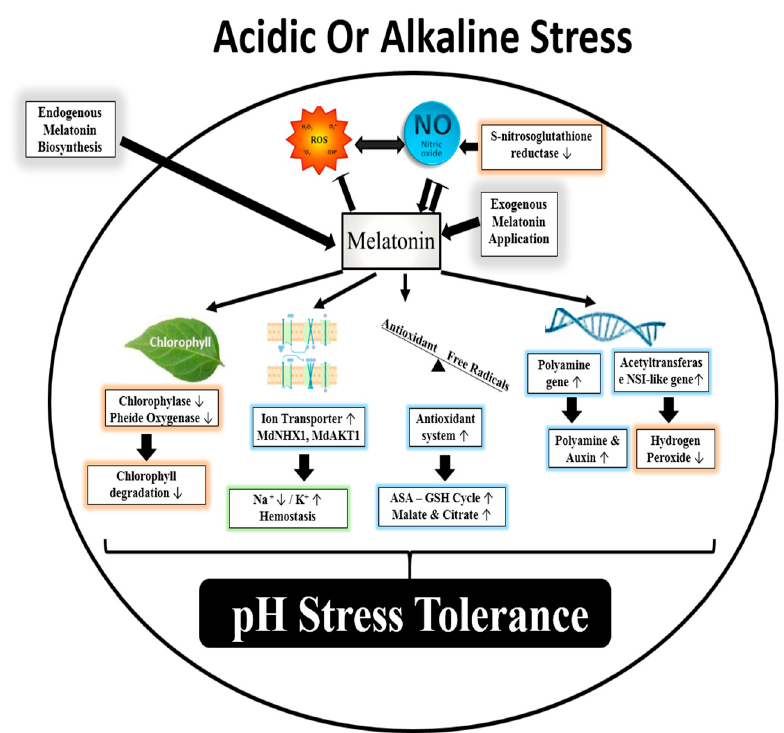
Figure 2. Model of melatonin action under acidity and / or alkalinity stress. Melatonin triggers the accumulation of auxin, polyamines, and nitric oxide. Furthermore, managing ion homeostasis by decreasing Na + content and increasing K + content. Melatonin reduced oxidative stress by triggering the antioxidant machinery and decreasing chlorophyll degradation. Exogenous melatonin induces NO generation, which subsequently upregulates the expression level of defense genes.